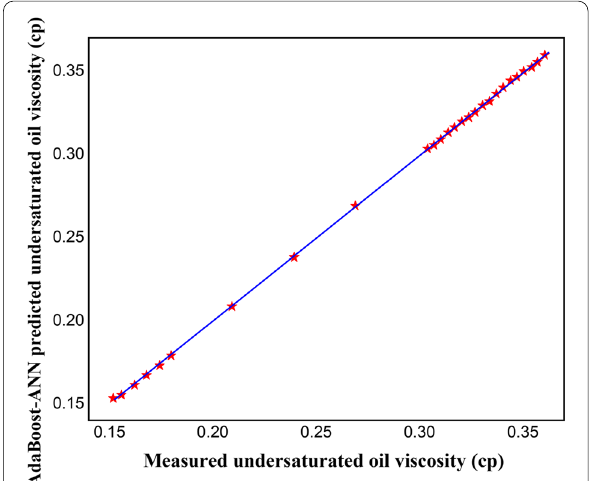
Fig. 14 Cross plot of GradientBoost predicted values versus measured values